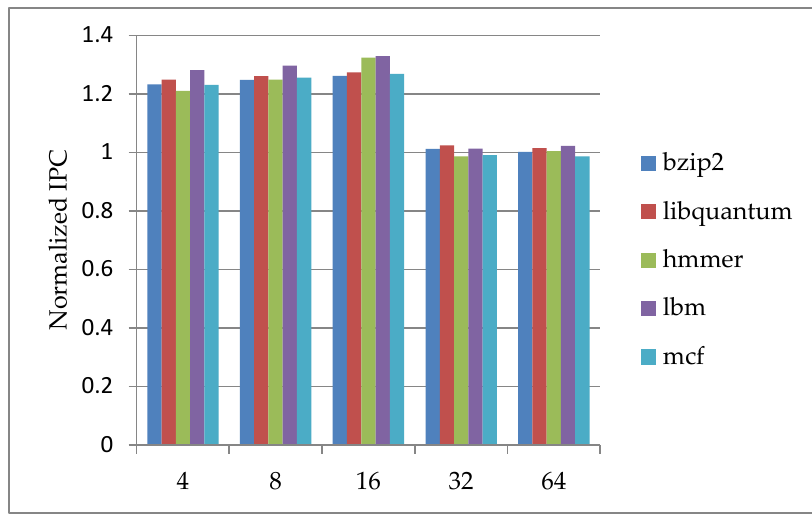
Figure 7. Comparison of IPC of Group 4 normalized to Group 3 in different Th.